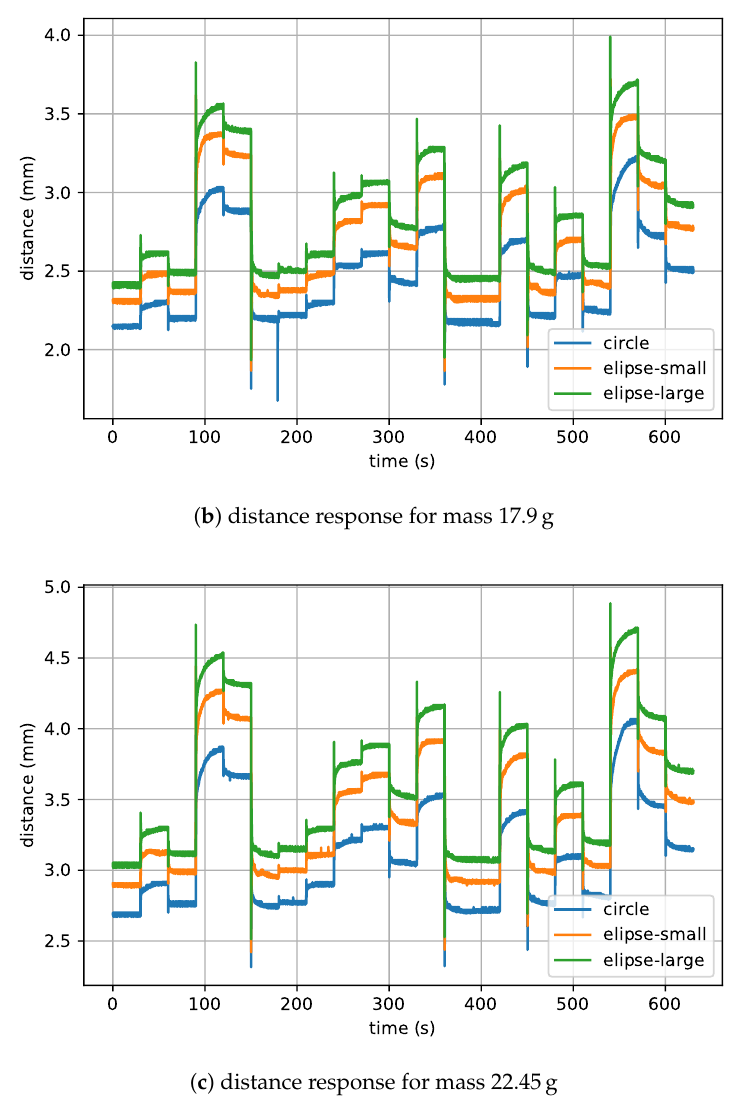
Figure 14. The response of actuators on voltage pseudo-random steps. Table 2. The increase in moving range for different